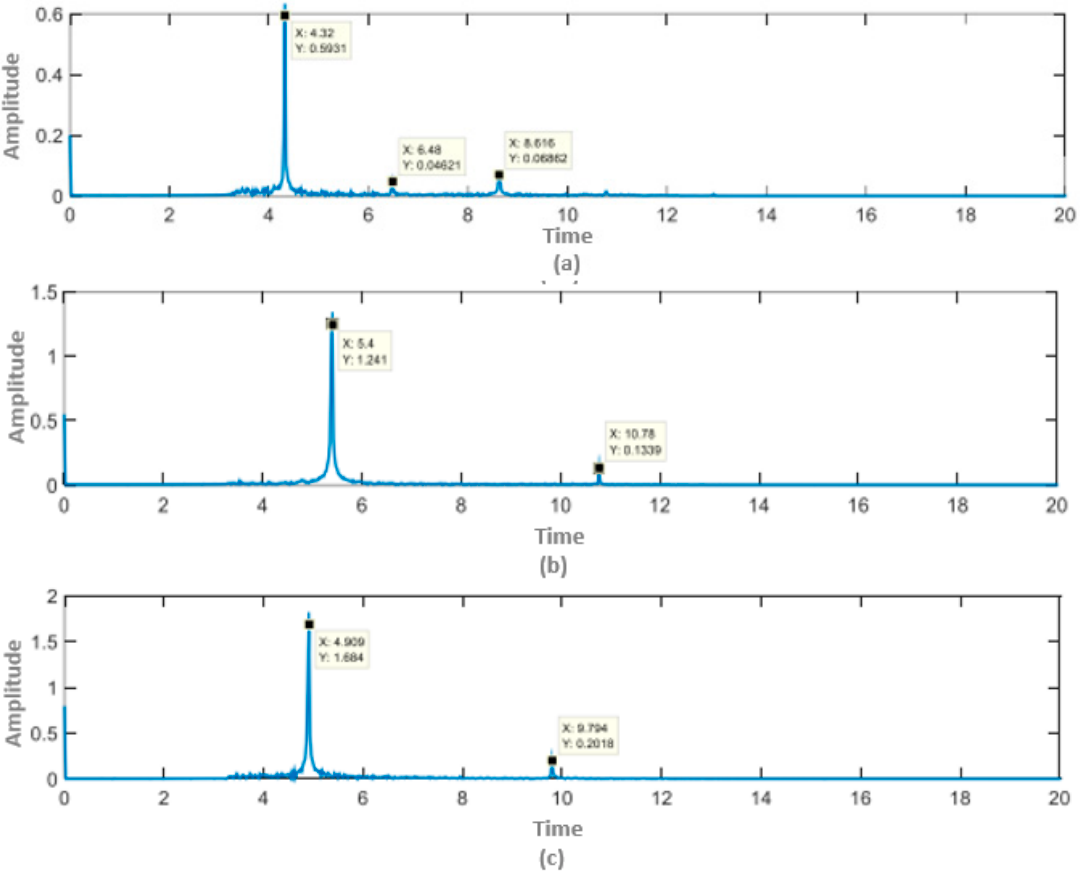
Figure 10. Experimental results of the gyro-based tremor-less case with respect to three levels: ( a ) easy, ( b ) medium, and ( c ) hard.